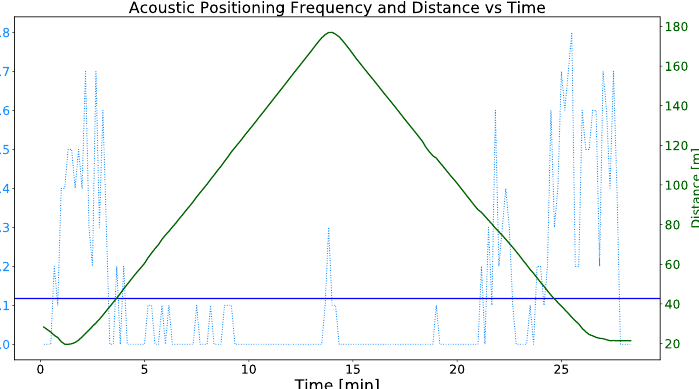
Figure 16. The green line represents the evolution over time of the distance between the ASV and the AUV while the latter performs the test bench mission template. The blue dotted line represents the frequency of the acoustic positioning corrections. Finally the blue line represents the mean of the acoustic positioning reception frequencies. The sample mean value of the acoustic positioning frequency is 0.117 Hz being the standard deviation 0.198